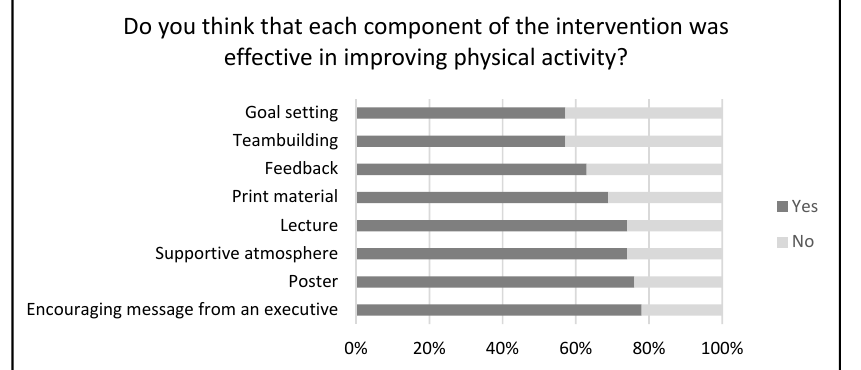
Figure 3. Post-intervention survey ( n = 54).